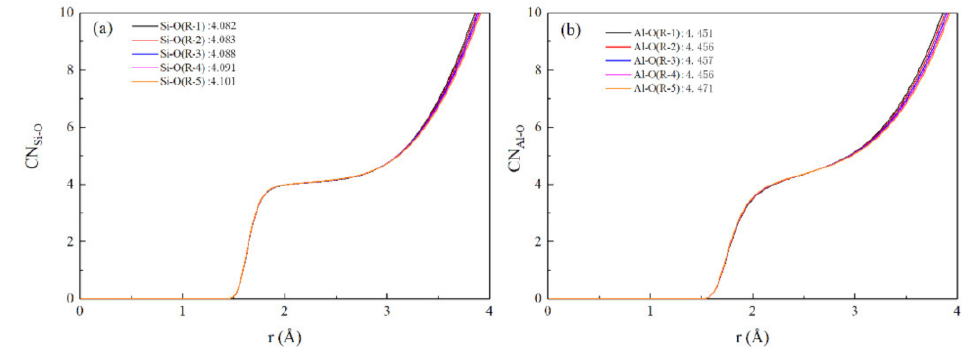
Figure 2. Coordination number of ( a ) Si-O and ( b ) Al-O with various CaO/Al 2 O 3